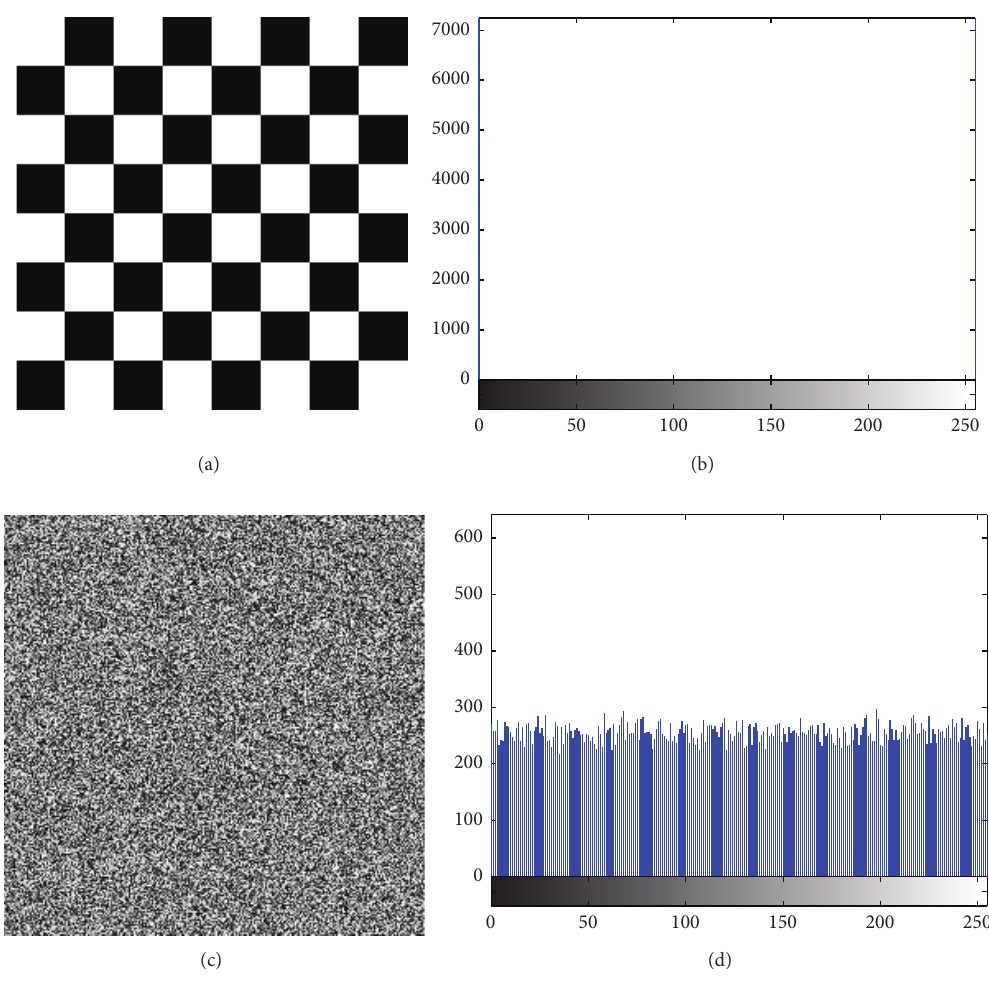
Figure 15: (a) Chess-plate image and (b) its histograms and (c) encrypted image and (d) its